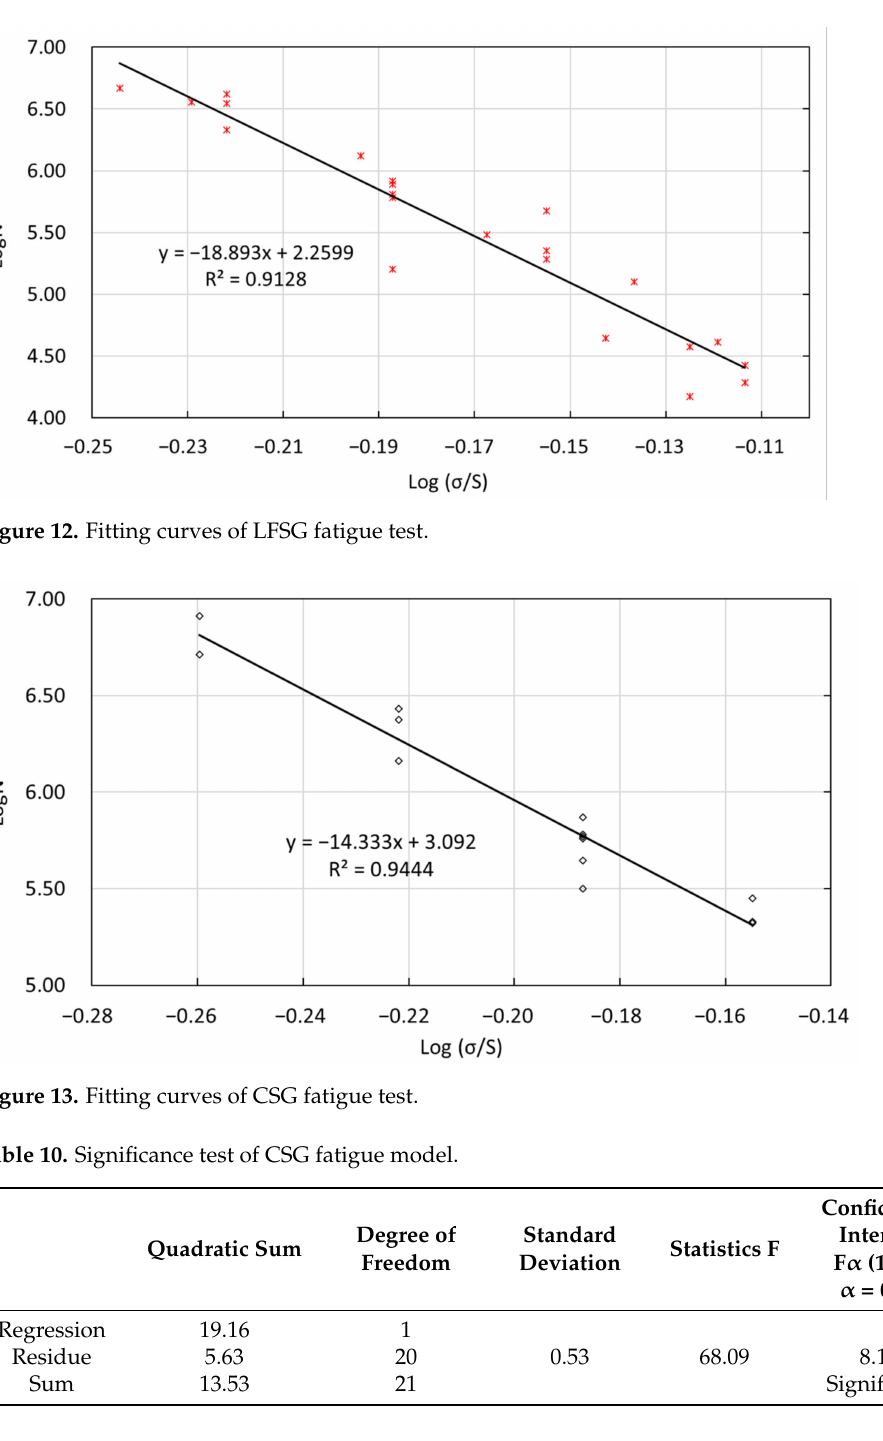
Table 11. Significance test of CSG fatigue